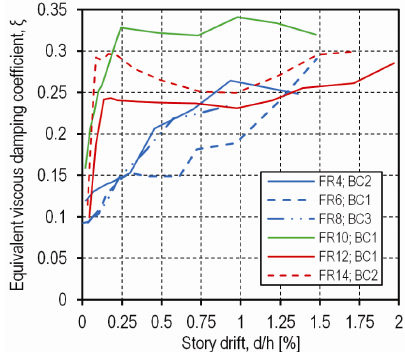
Fig. 10. Equivalent viscous damping coefficient ξ calculated at hysteresis turning